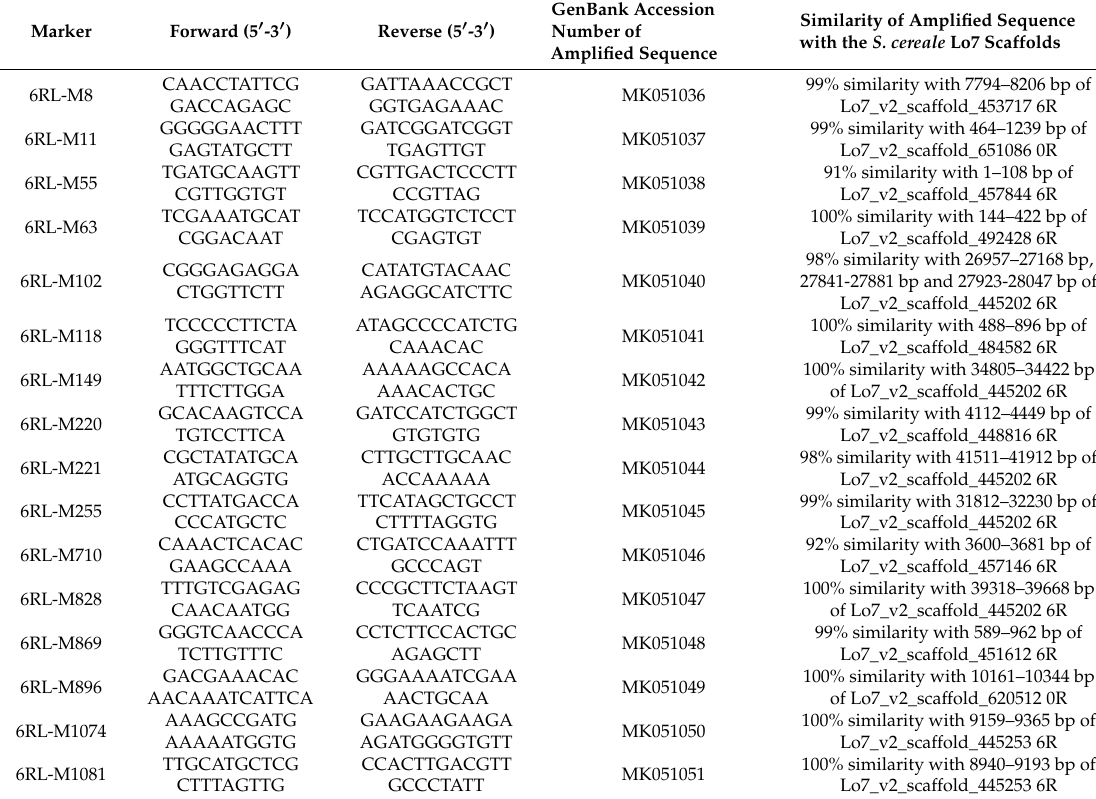
Table 2. 6RL Ku minichromosome-specific markers and the similarity between the sequences amplified by the markers and the S. cereale Lo7